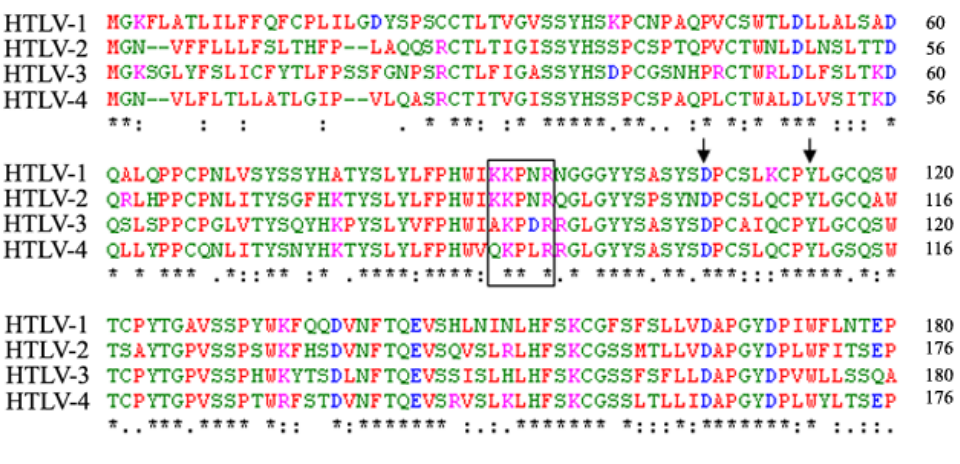
Figure 4. Alignment of the amino acid sequence of the HTLV-1 RBD with the corresponding regions of the HTLV-2, HTLV-3 and HTLV-4 SU. The KKPNR motif of HTLV-1 that mediates direct binding to NRP-1 is boxed and the D106 and Y114 residues that mediate binding to GLUT1 are indicated by arrows. The alignment was performed with the Clustal W program using the following accession numbers: HTLV-1: Genbank AAC82582; HTLV-2: GenBank M10060; HTLV-3: GenBank EU649782 and HTVL-4: NCBI NC_011800. An asterisk indicates identical residues, a colon indicates conserved substitutions and a period indicates semiconserved